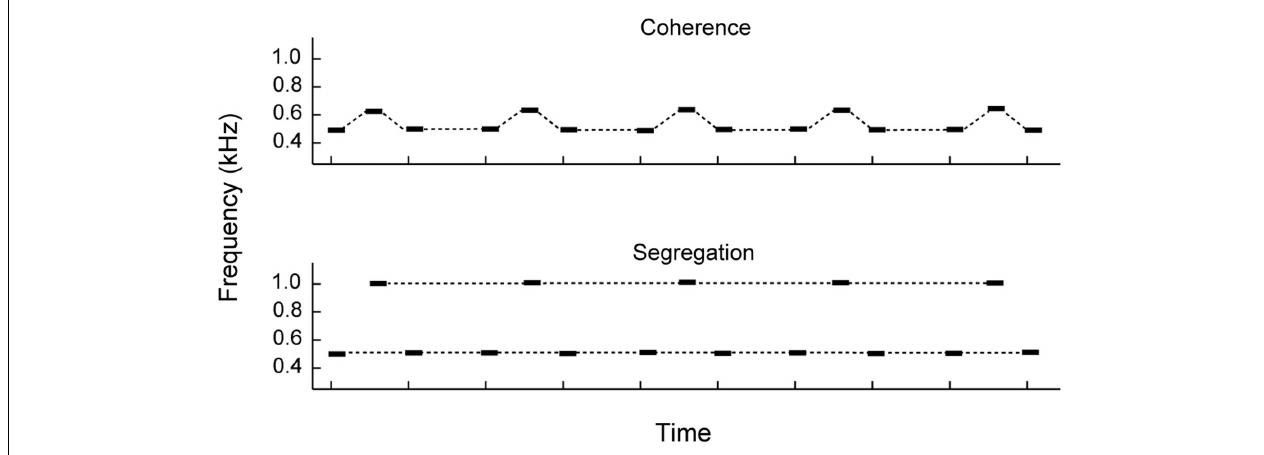
FIGURE 1 | In auditory stream segregation experiments, low and high tones are alternated repeatedly. When the frequency difference between the tones is small (top), this typically leads to perception of one coherent stream. For large frequency differences (bottom), one is more likely to be heard as two segregated